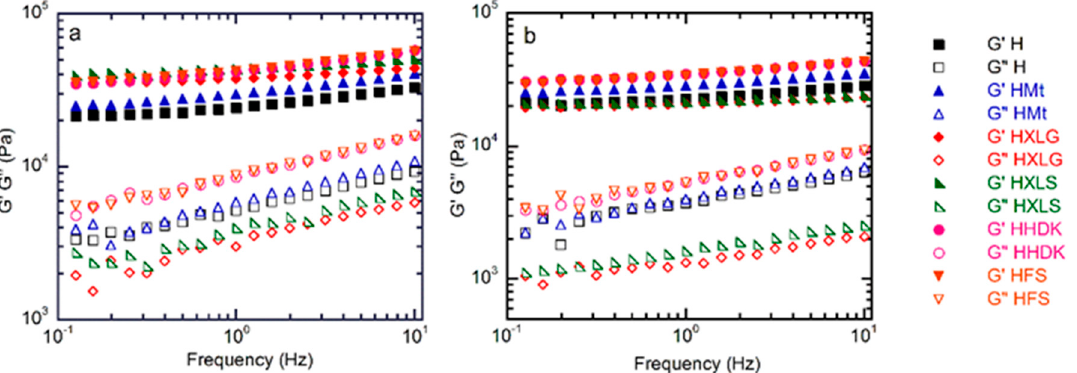
Figure 6. Frequency sweep rheological measurements on the (nano)composite hydrogels ( a ) in the as-prepared state and ( b ) after swelling at equilibrium.